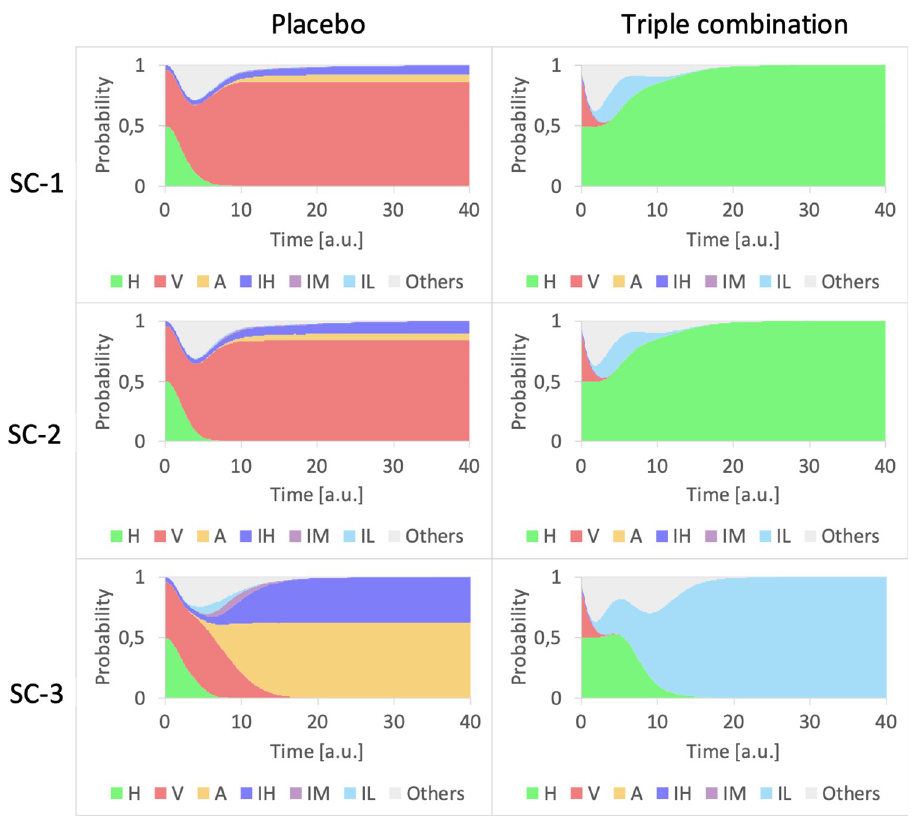
Fig 6. Triple combination compared with placebo. The first column represents the placebo treatment whereas the second column the triple combination of Remdesivir, Baricitinib, and Corticosteroid, administered together. The rows correspond to the different scenarios. The colored areas represent the cumulative probability to measure a certain percentage of phenotypes for each biopsy. Simulations were performed with MaBoSS [37].